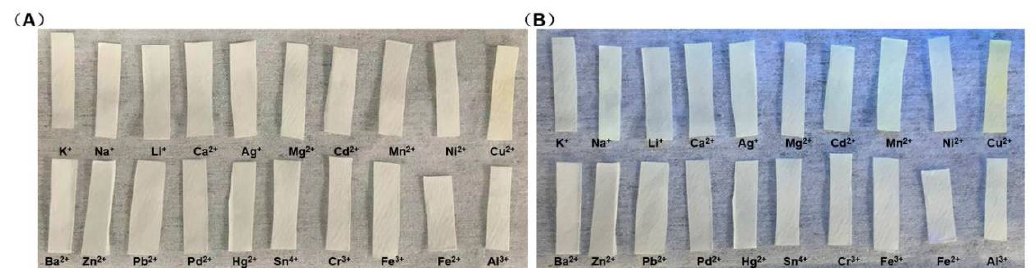
Figure 5. ( A ) Photographs of test strips immersed in aqueous solutions of different analytes in ambient light. ( B ) Photographs of test strips immersed in aqueous solutions of different analytes under a 365 nm UV lamp.